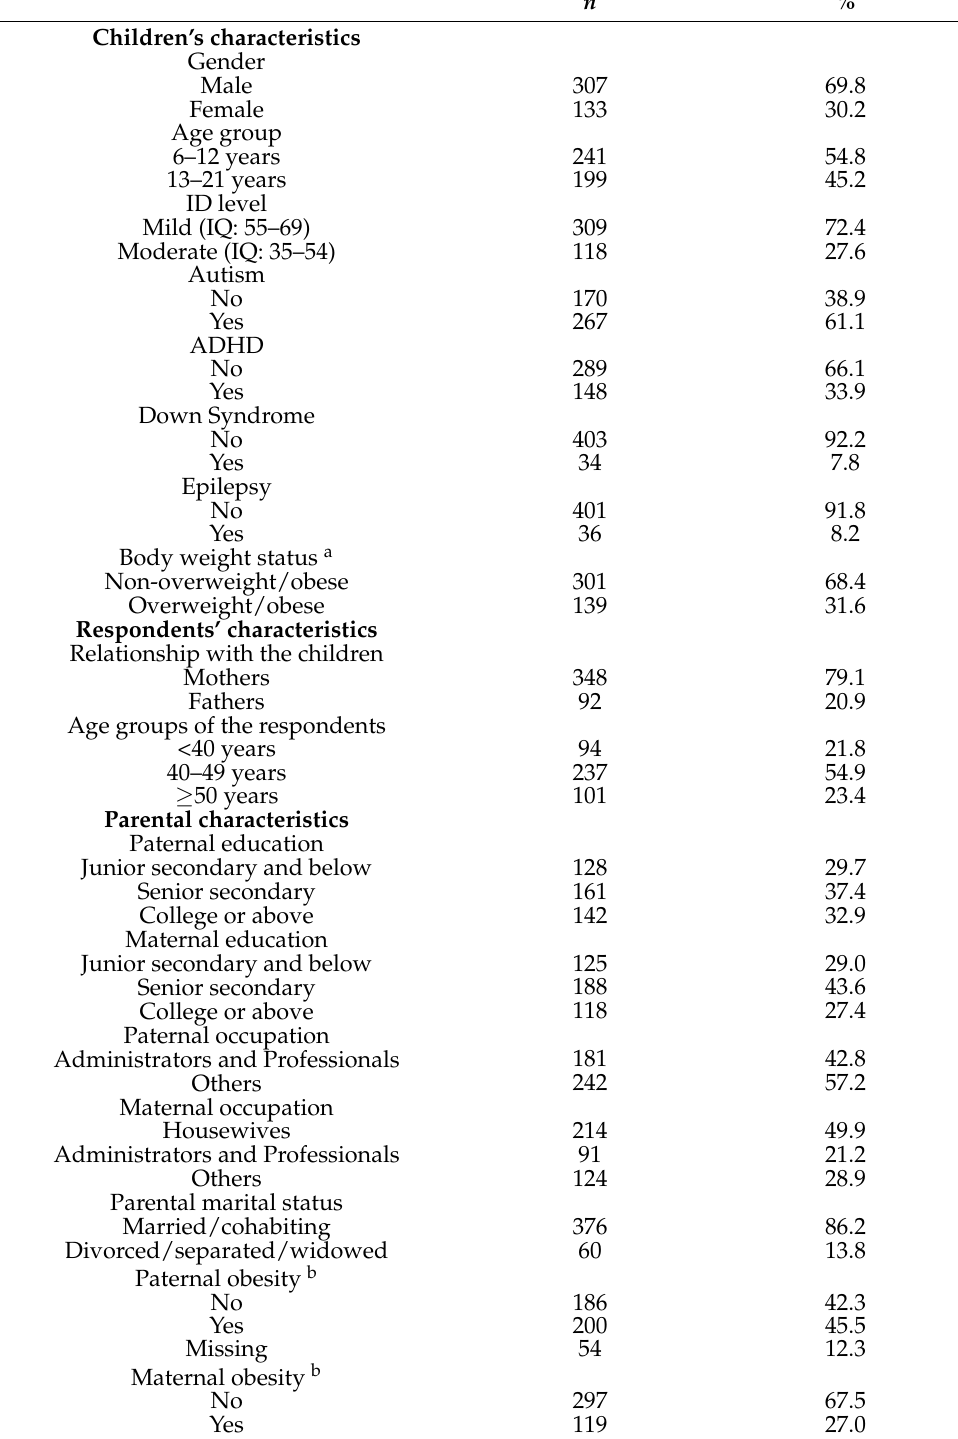
Table 1. Background characteristics of the participants ( n =